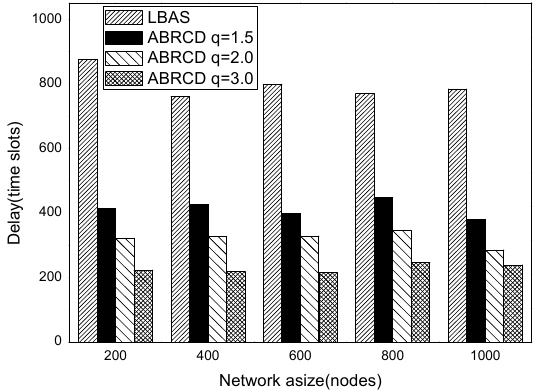
Figure 46. The impact of network size with fixed | T | = 80 on delay.